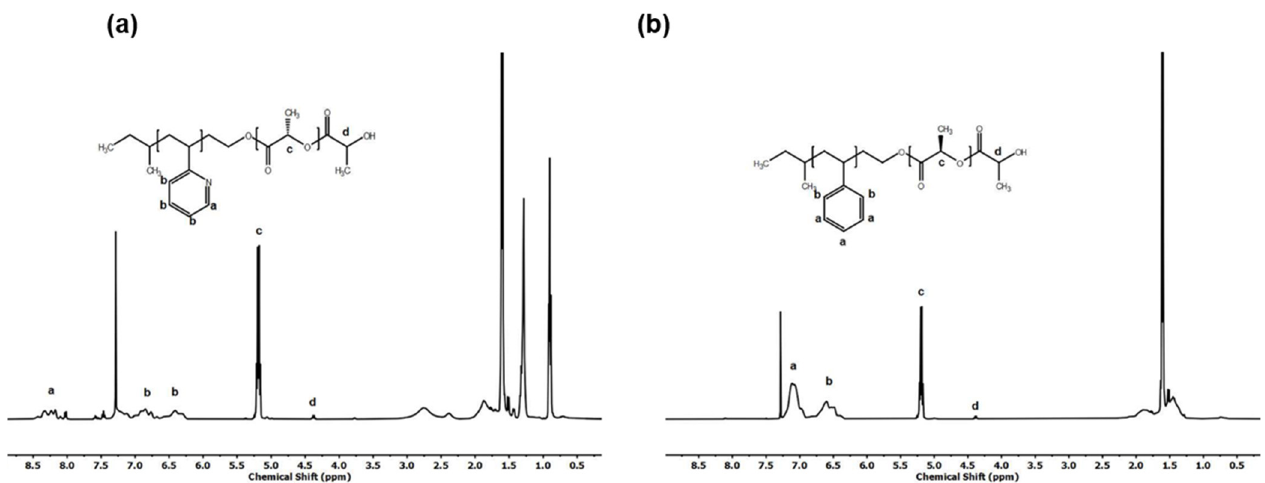
Figure 2. 1 H NMR spectra of ( a ) P2VP 5.5 - b -PLLA 5.6 , and ( b ) PS 6.2 - b -PDLA 5.5 diblock copolymers (400 MHz, CDCl 3 , 25 °C).